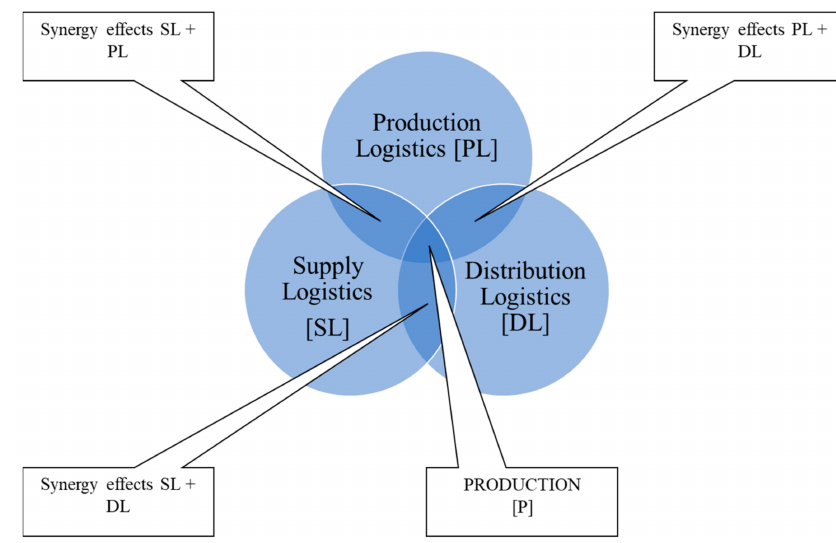
Figure 3. Exploitation areas of synergy effects according to the PL9A